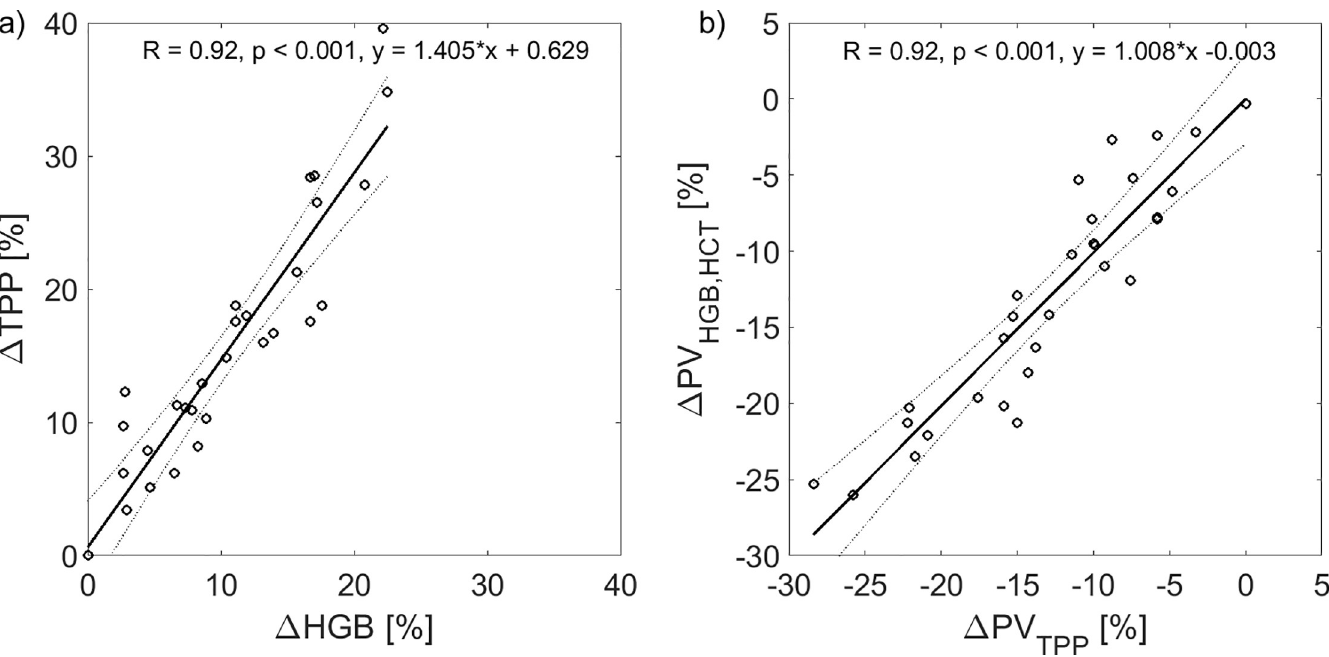
Fig 6. Correlation between dialysis-induced changes in total plasma protein, hemoglobin and plasma volume estimates. a) Relative changes of hemoglobin ( Δ HGB) paired with relative changes of total plasma protein ( Δ TPP); b) Comparison between the relative plasma volume (PV) changes calculated from changes in total protein concentration (TPP, see Eq 4) or calculated from changes in whole blood hemoglobin (HGB) and hematocrit (HCT), assuming the constant F-cells ratio of 0.9. Data shown for all hemodialysis sessions with linear regression fit (solid lines) and 95% confidence bounds (dotted